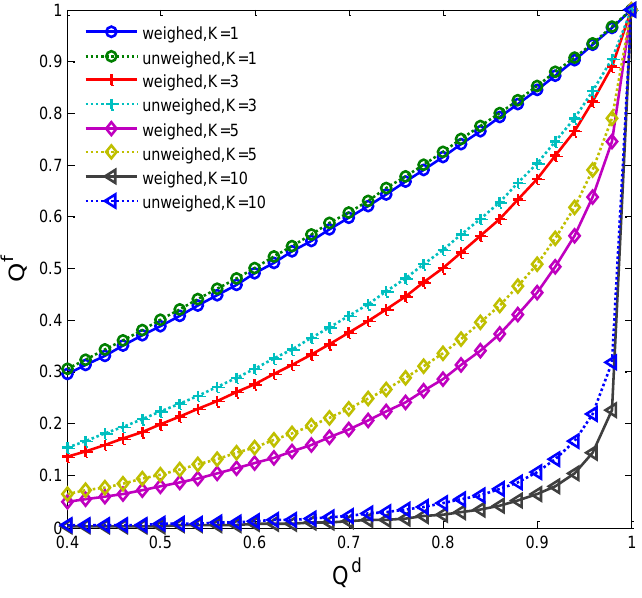
Figure 6. False alarm probability